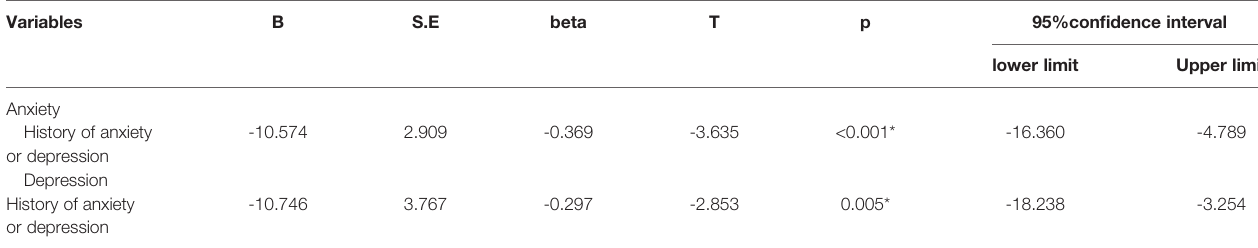
TABLE 6 | Linear regression analysis for anxiety and depression in